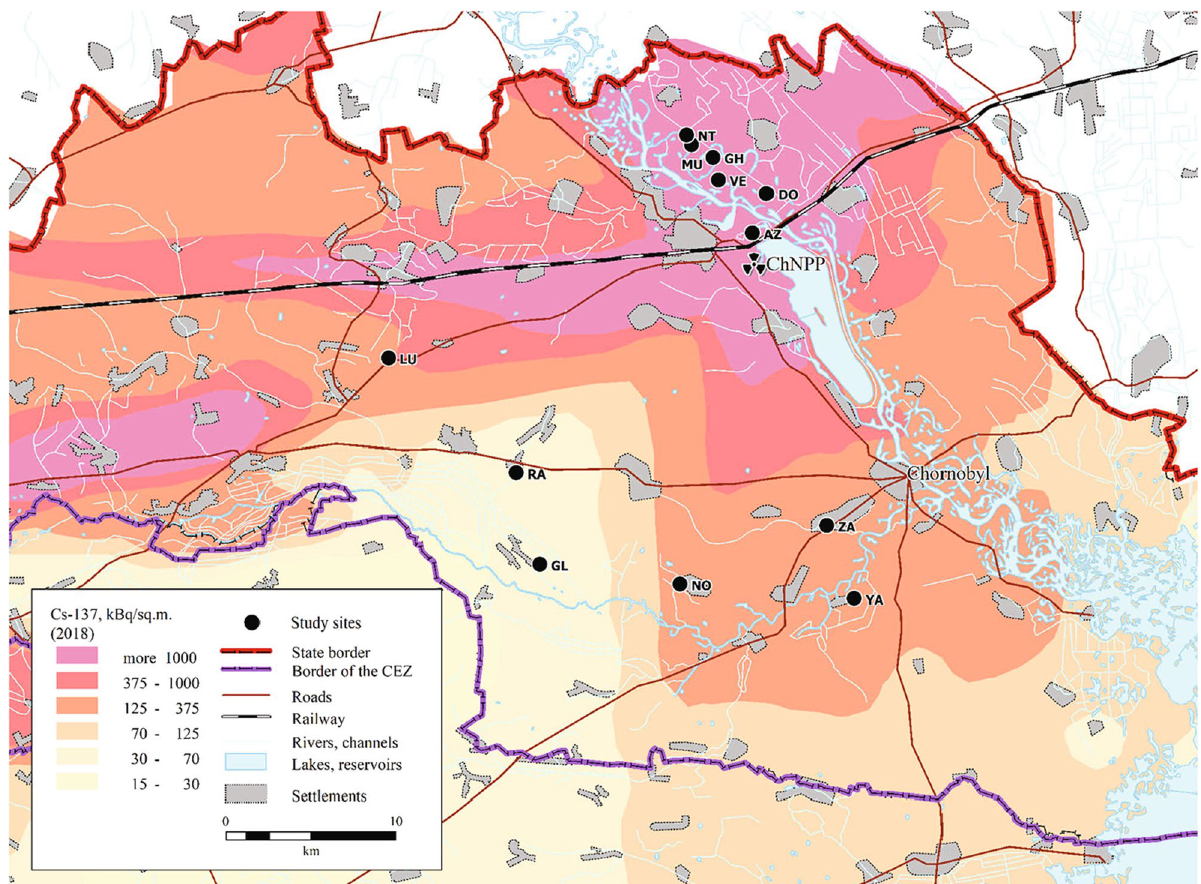
Figure 1. Map showing the localities where males of the Eastern tree frog ( Hyla orientalis ) were sampled. The abbreviations refer to the locality name. Vershina (VE), Azbuchin (AZ), Muravka (MU), Glyboke Hydro (GH), Northern Trace (NT), Dolzhikovo (DO), Lubianka (LU), Novosiolki (NO), Zalesie (ZA), Yampol (YA), Glinka (GL), and Razjezzheie (RA; see Table 1 for details). Map created with MapInfo Pro 17.0.3 (https:// www. preci sely. com/ produ ct/ preci sely- mapin fo), the underlying 137 Cs soil data (decay corrected to spring 2018) is derived from the Atlas of Radioactive Contamination of Ukraine (http:// radat las. isgeo. com. ua/) 37